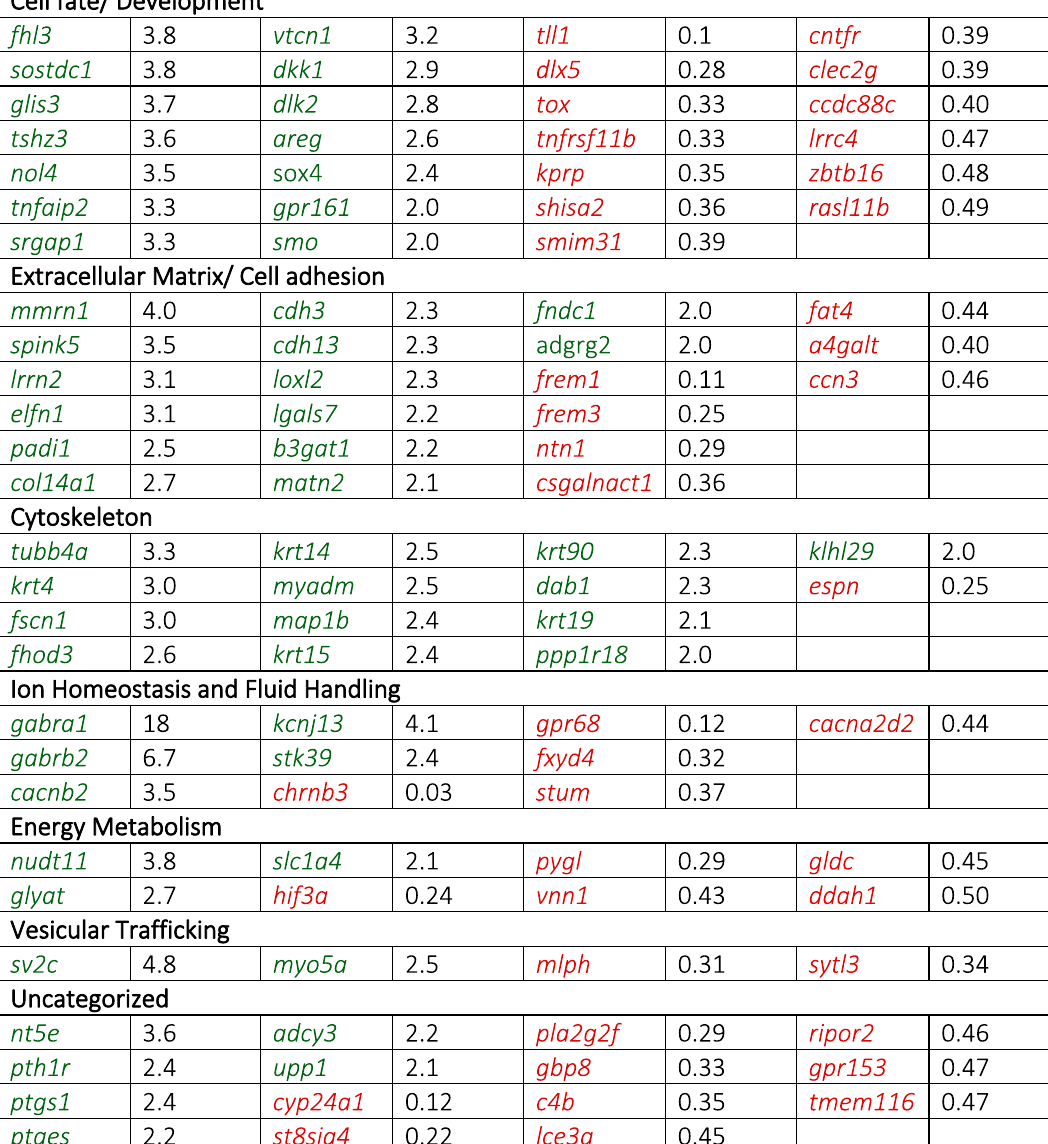
Table 3. Organization of genes with altered expression into functional categories. Genes with increased expression are written in green text and red indicates decreased expression. Genes in the table are ordered from most to least altered in both the increased and decreased categories. To the right of each gene name are fold changes indicating change of expression in slc4a11 −/− mice relative to slc4a11 + / + . Additional information on the role of each gene and the significance of each alteration can be seen in Suppl Table 1. Functional categories are indicated in bold in the table. Categories are ordered by number genes in each